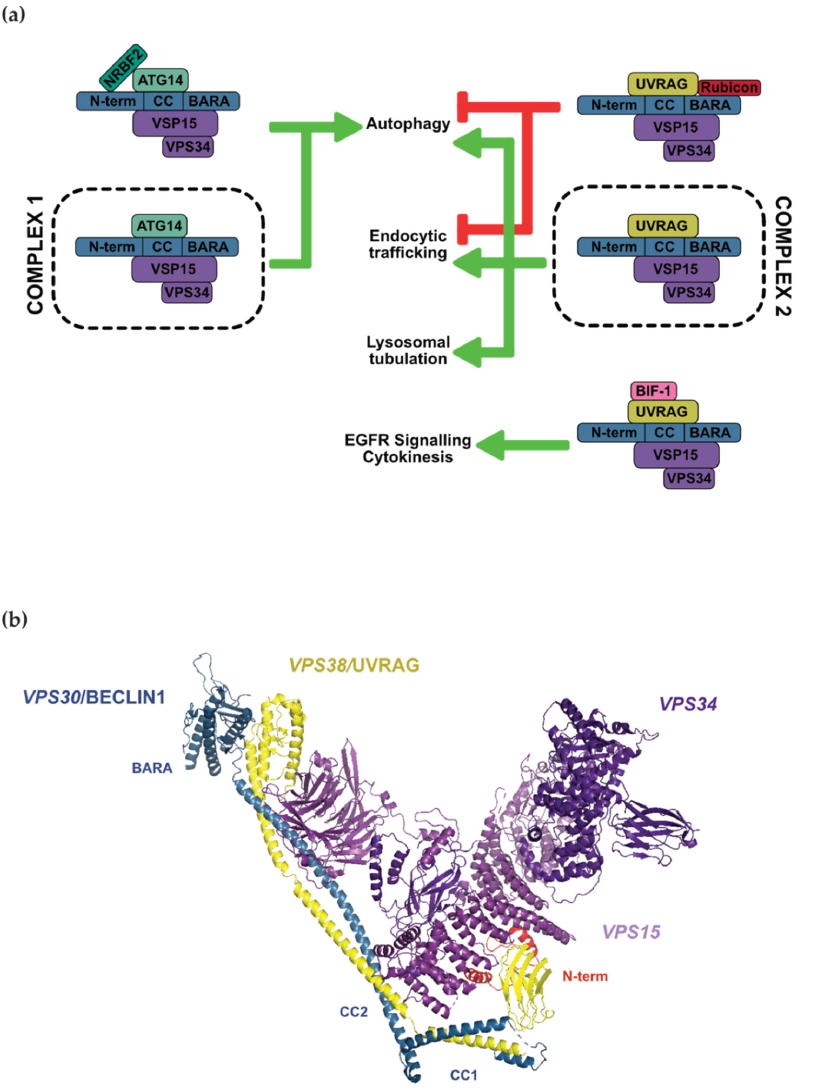
Figure 1. ( a ) PI3K Class III complexes, subcomplexes, and their associated cellular functions. BE- CLIN1 is indicated in blue with its protein domains listed. Green arrows indicate functions promoted by complexes, whereas red indicates pathways inhibited by complexes. ( b ) Yeast C2 crystal structure resolved to 4.40 Å by X-ray diffraction: VPS30 (BECLIN1 homolog, blue), VPS38 (UVRAG homolog, yellow), VPS15 (purple), VPS34 ( deep purple). Red helices have been tentatively assigned to the Beclin1 N-terminal region that contains the BH3 domain (PDB ID: 5DFZ). Structural determination of human and yeast C1 and C2 reveals similar overall three- dimensional conformations between the two complexes. Both complexes are dynamic and take on a “V” shape, with VPS34 and VPS15 located on one catalytic arm of the “V” and BECLIN1 and either ATG14 or UVRAG on the other regulatory arm of C1 and C2, respec- tively [46–49]. In contrast to earlier studies [24], these structural studies proposed that there is no direct contact between VPS34 and BECLIN1 but, instead, that this is mediated by VPS15 [46,48]. Another difference between these studies and earlier studies that sug- gested anti-parallel coiled-coil alignments between BECLIN1 and either ATG14 or